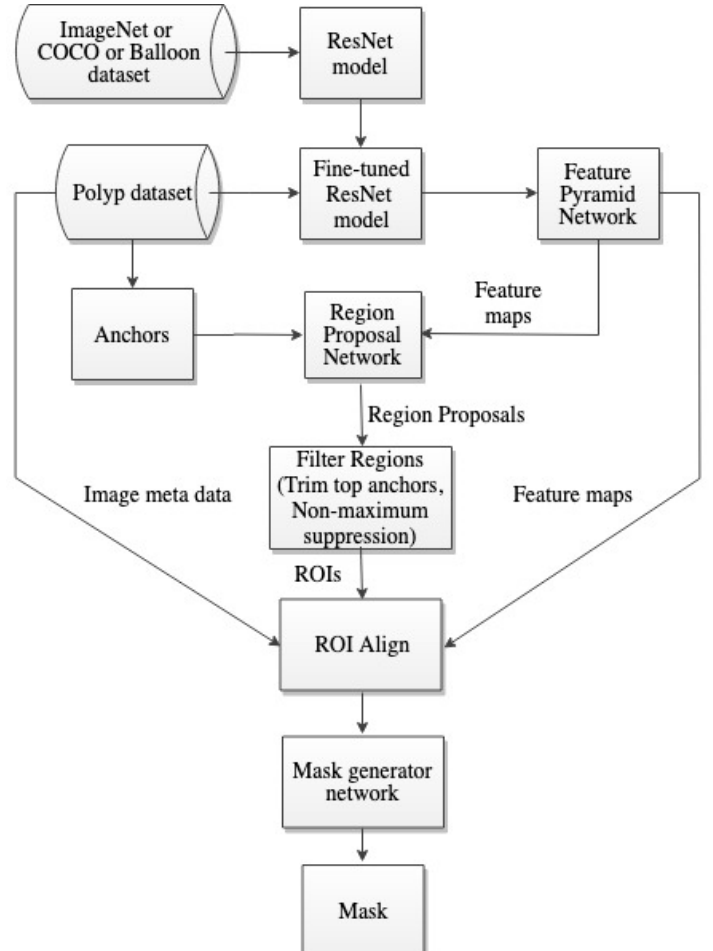
Figure 3. Flowchart depicting the proposed approach.